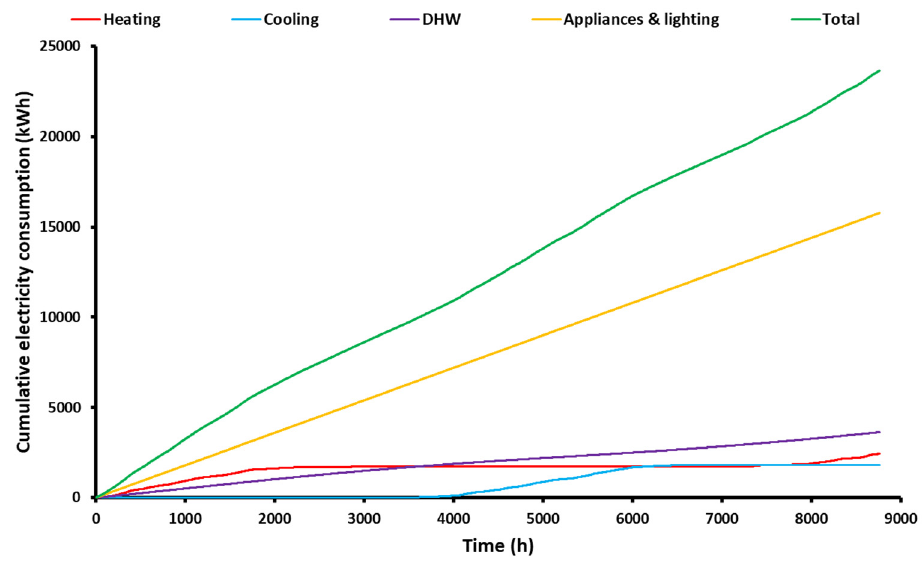
Figure 8. Cumulative electricity demands for covering the different needs of the studied building.